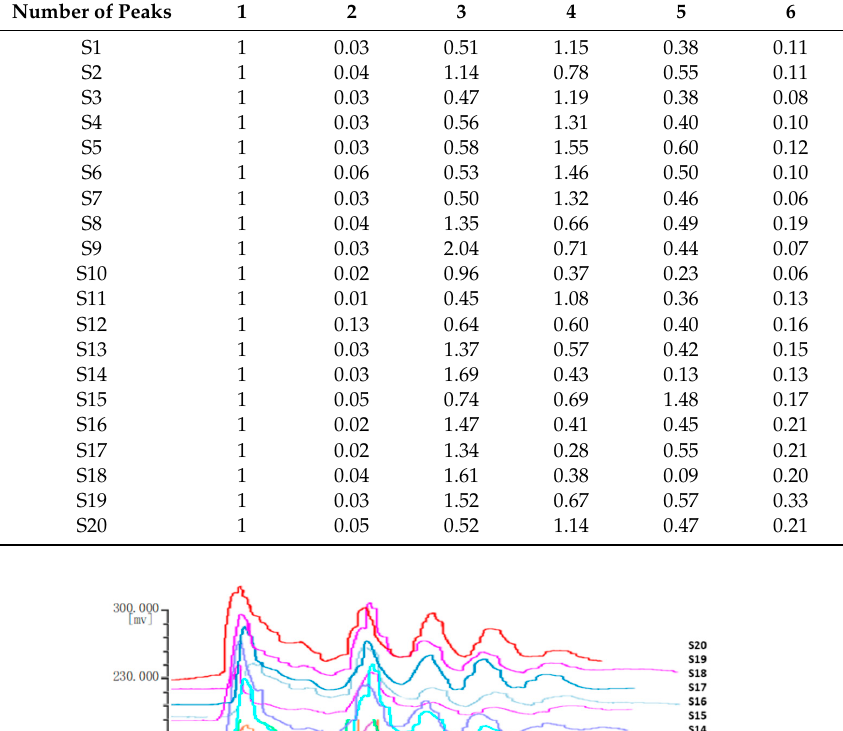
Table 5. Relative area of peaks determined using Psorslea corylifolia L. extracts.